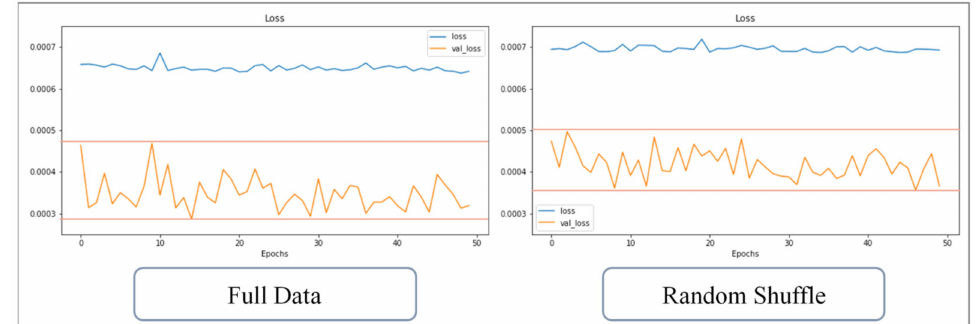
Figure 16. Change of loss value with or without random shuffle (50 runs).